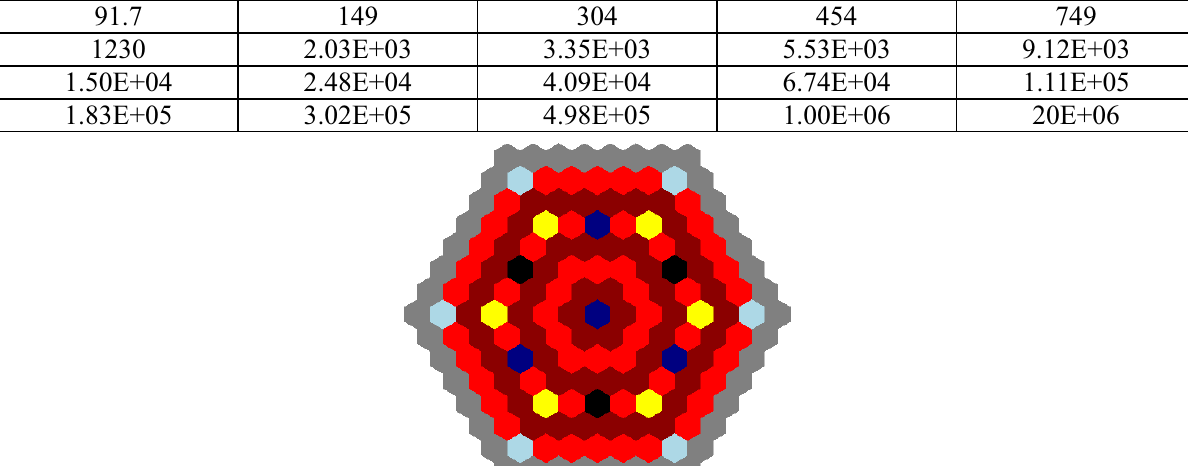
Figure 3. Homogenized model at the assembly level (Red = Fuel assembly; Silver = Reflector; Light blue = Thermal IPS; Navy = Fast IPS; Yellow = Control rod bank; Black = Safety rod